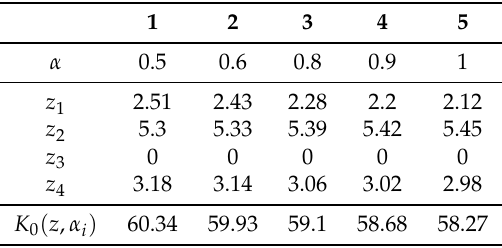
Table 3. Finding the maximum satisfaction degree with α